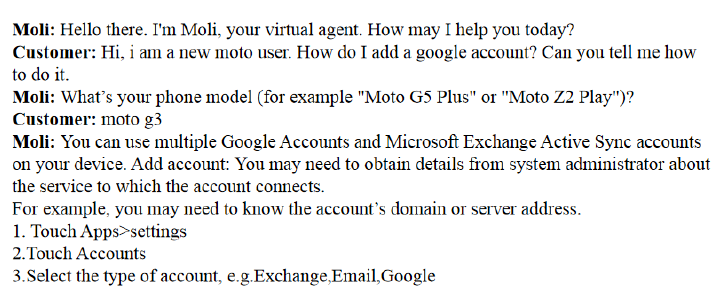
Figure 1. Example chat about an “email account